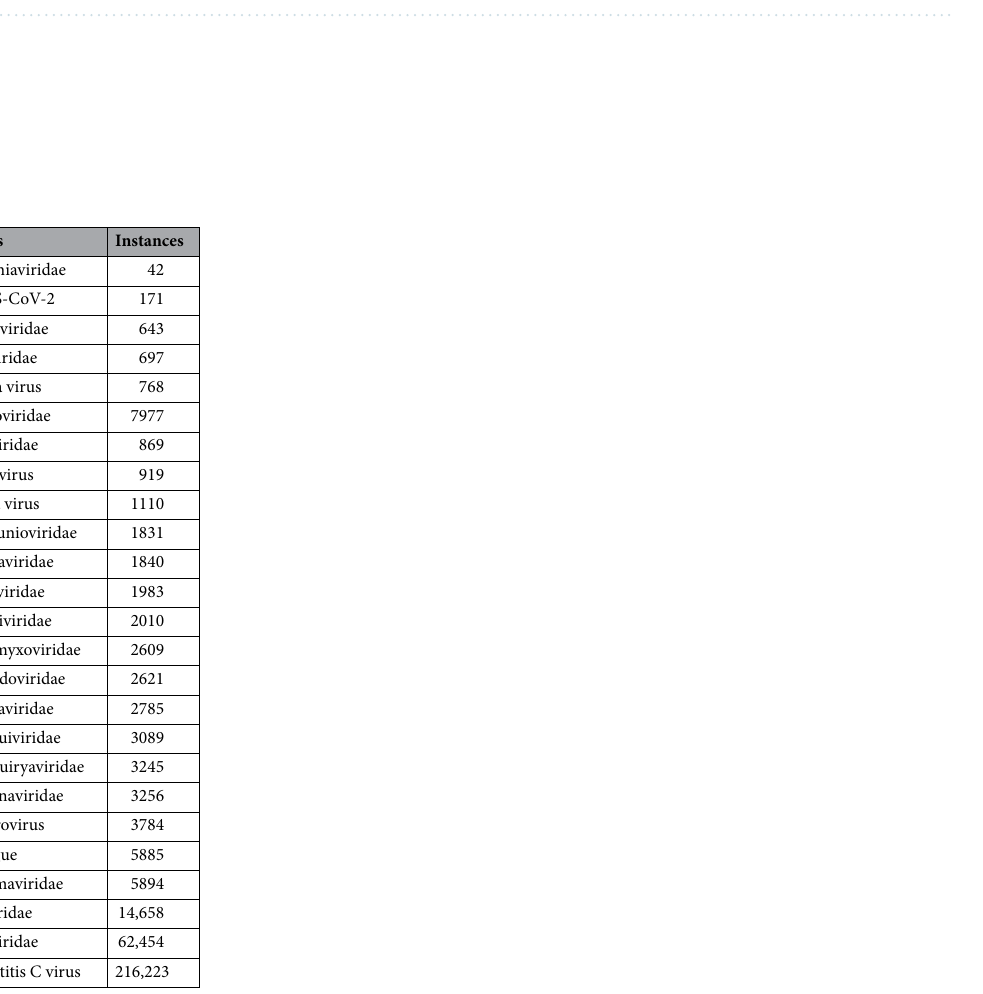
Figure 24. A binary classification problem, wherein the hyperplane created by the support vector machine has 2 dimensions.